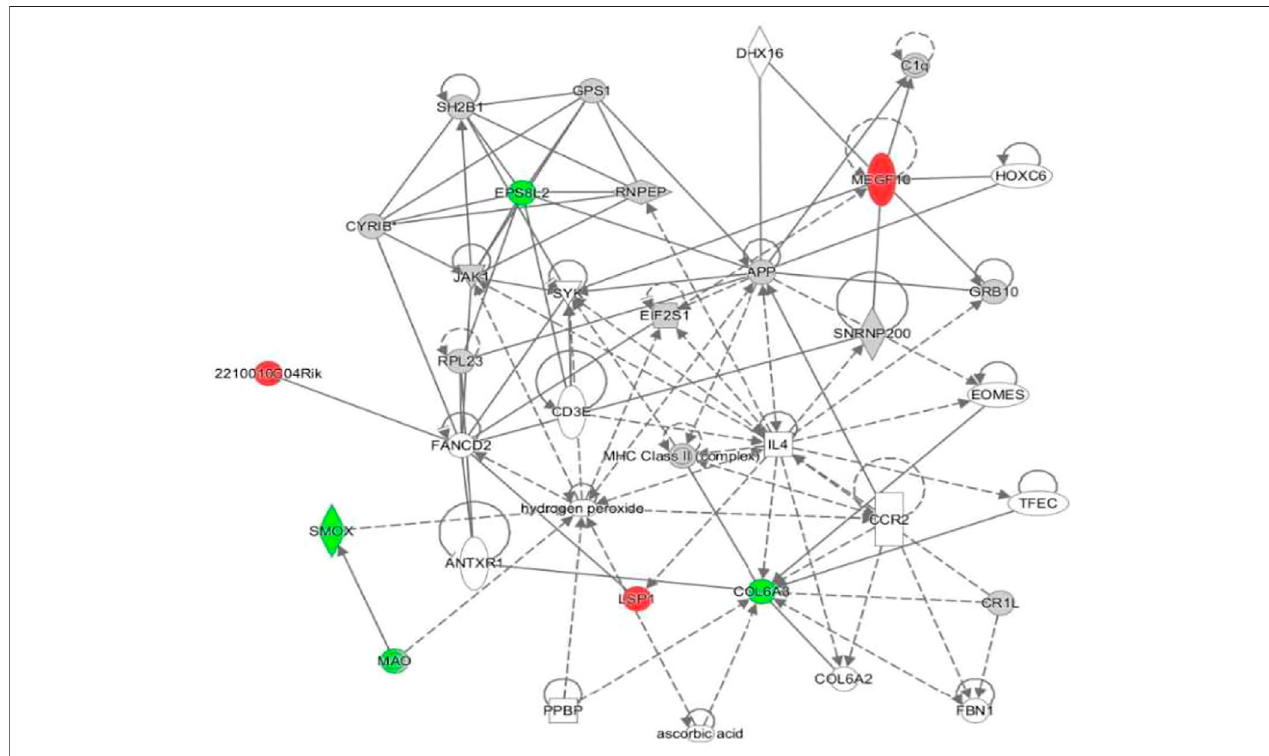
FIGURE7| Visualrepresentation oftheproteinnetworkforhippocampal tissuestreatedwith5-FUand leucovorin.Nodulesrepresentspeci fi ccharacteristics.Red representsupregulationofproteins.Greenrepresentsdownregulationofproteins.Grayidenti fi esproteinsthatwereinsigni fi cantlyexpressedbutincludedinthenetwork